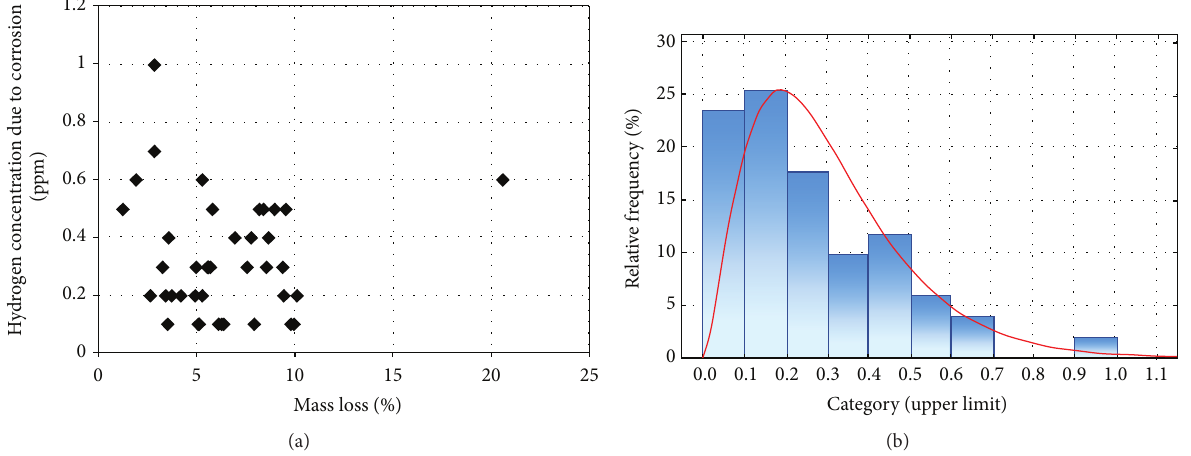
Figure 11: (a) Hydrogen concentration due to corrosion for salt spray samples (90 days of exposure). (b) Gamma distribution for hydrogen